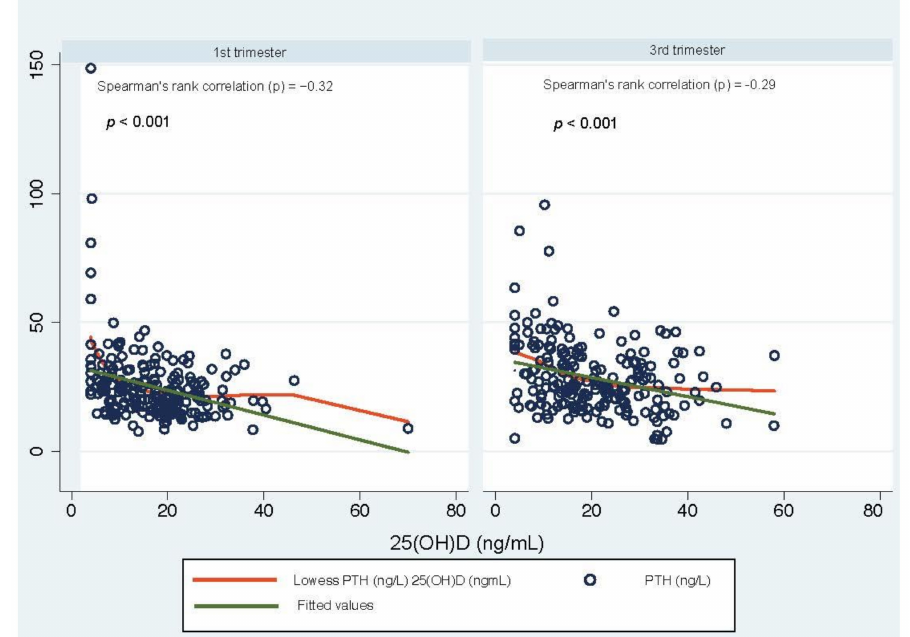
Figure 2. Scatterplot of PTH (ng/L) versus 25(OH)D (ng/mL) concentrations with smoothing fit. Left: 1st trimester group: Right: 3rd trimester